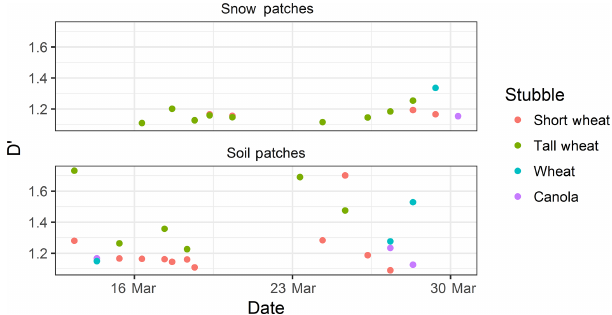
Figure 7. Time series of fitted D (cid:48) parameter with respect to snow and soil patches for various land covers over the course of snowmelt.